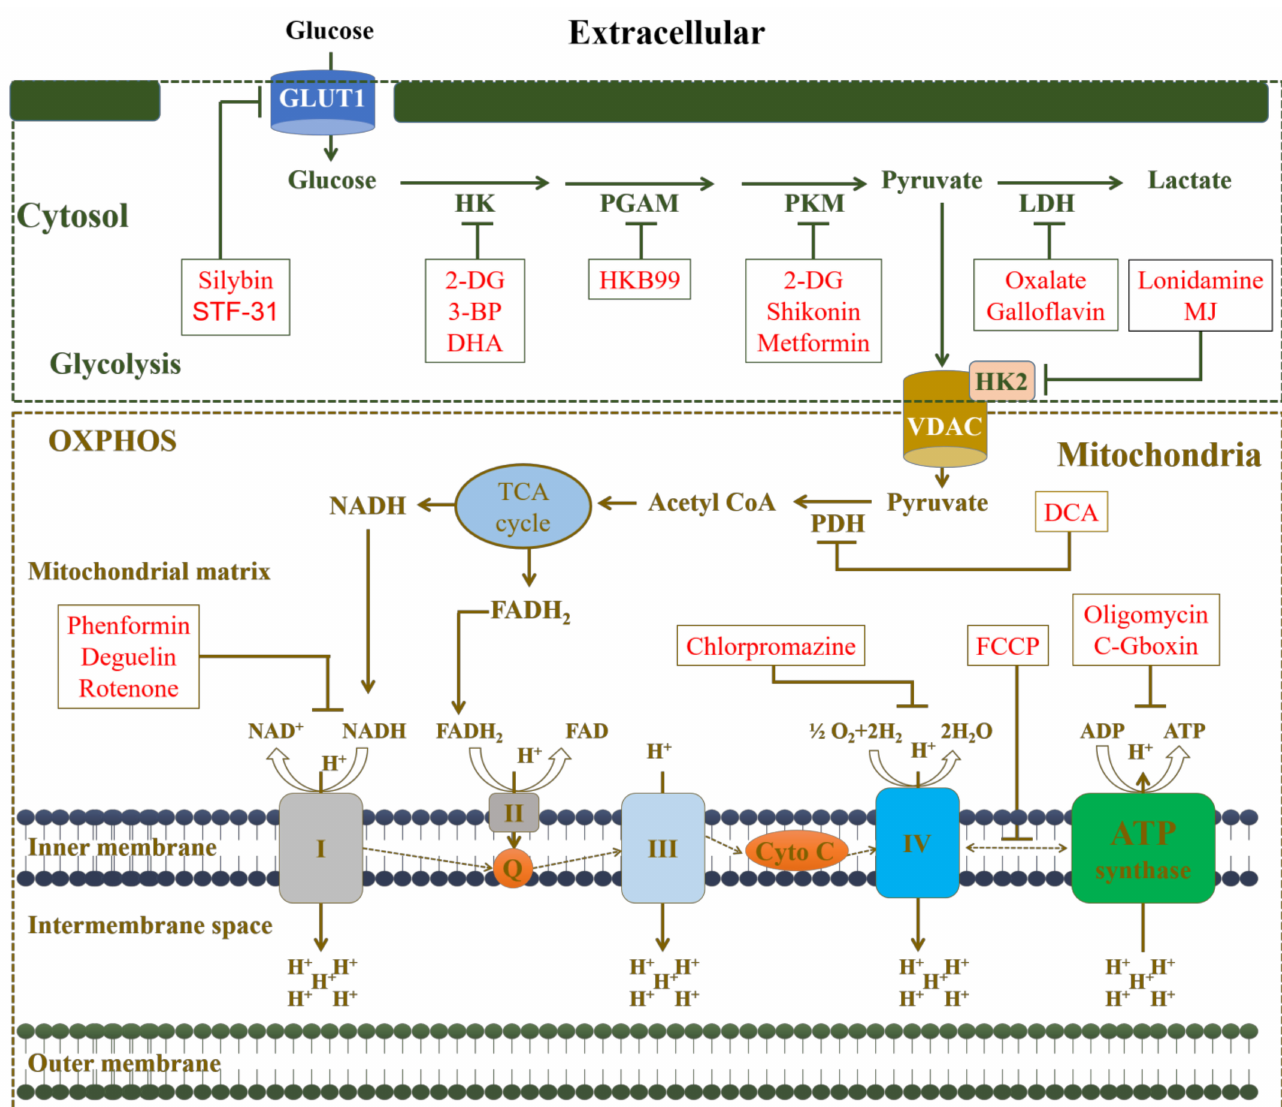
Figure 3. Drugs targeting glycolysis and oxidative phosphorylation (OXPHOS) to sensitize chemother- apy resistance cancer cells. The cells use glucose as their primary metabolic substrate, which is broken down into pyruvate by glycolysis, which produces adenosine triphosphate (ATP), and nicotinamide adenine dinucleotide (NAD) plus hydrogen (H) (NADH) in the presence of various glycolysis enzymes, including hexokinase (HK), phosphofructokinase (PFK), and phosphoglycerate mutase (PGAM), etc. In normal cells, most pyruvate is transported into mitochondria for further oxidation, whereas in cancer cells most pyruvate is converted to lactate in the presence of lactate dehydrogenase (LDH). The tricarboxylic acid (TCA) cycle is fueled by acetyl-CoA, which produces NADH, flavin adenine dinucleotide (FADH 2 ), ATP, and metabolic intermediates required for proliferation. The mitochondrial respiratory chain complex (RCC) or electron transport chains (ETC) are composed of complex I, complex II, complex III, complex IV and complex V (ATP synthase), that catalyzes the oxidation of reducing equivalents, primarily NADH and FADH 2 , in the IMM using the terminal electron acceptor oxygen (O 2 ). The ETC receives NADH and FADH 2 from the TCA cycle in the mitochondrial matrix, each of which provides a pair of electrons to the ETC via complexes I and II, respectively. The ETC complexes (complexes I–IV), the ATP synthase, the IMM, two diffusible electron carriers, and substrate transporters in IMM form the OXPHOS system. Ubiquinone (Q), which can be reduced to ubiquinol (QH 2 ), is the product of electron transfer from complex I or II. Complex III oxidizes ubiquinol, allowing one electron to continue its journey via cytochrome c at